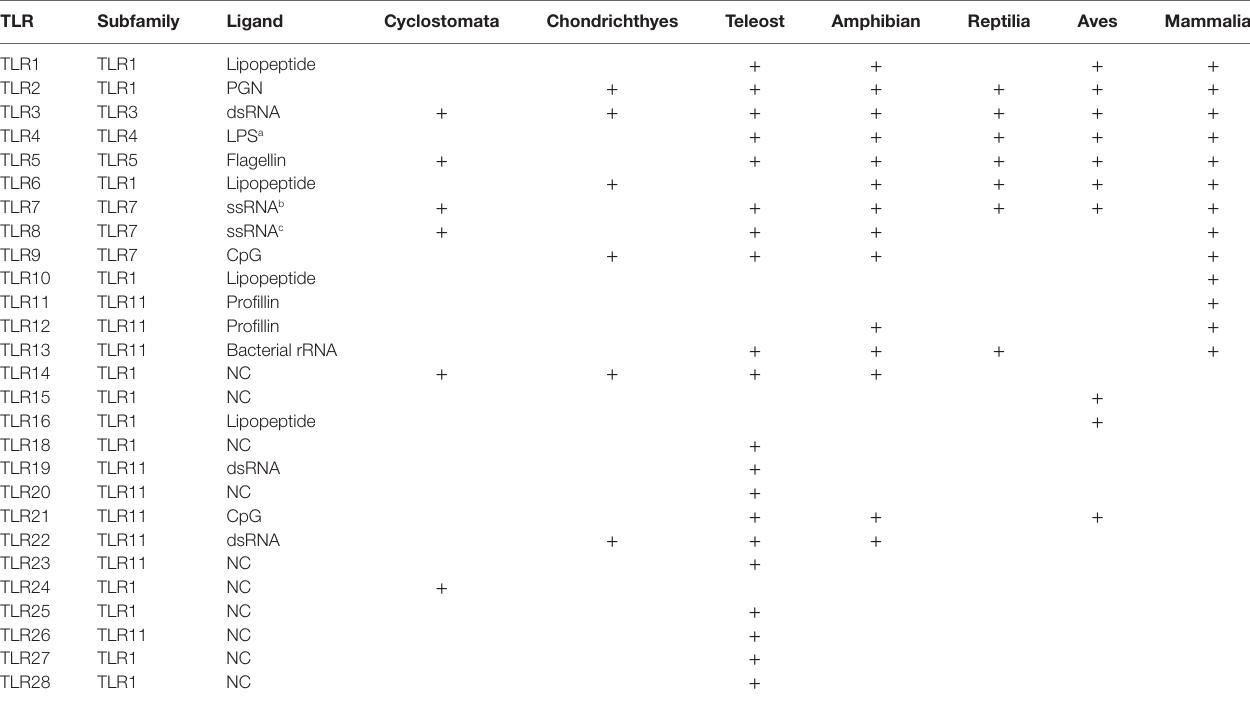
TABLe 2 | Summary of toll-like receptors (TLRs) in